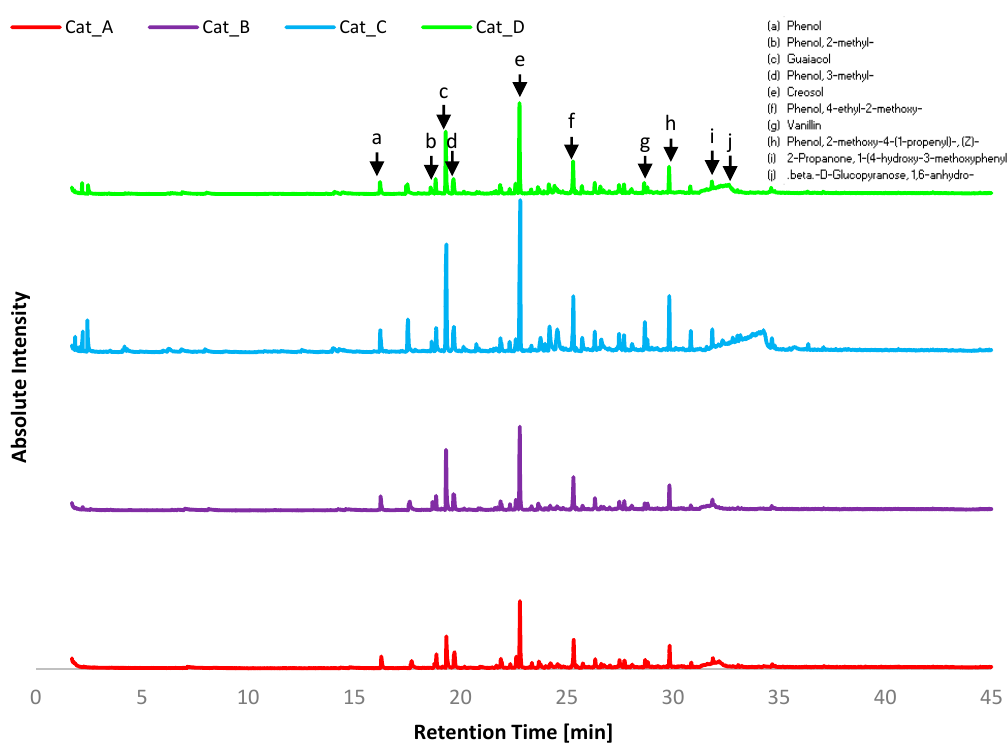
Figure 3. GC-MS chromatograms for bio-oil from catalytic pyrolysis using Catalytic Mixtures A–D. Common compounds are listed as a–j.